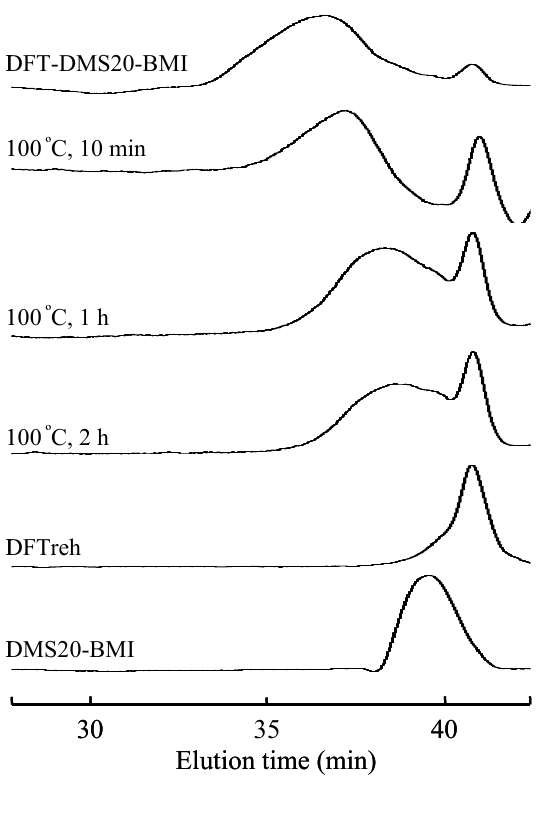
Figure 8. GPC traces of DFT-DMS20-BMI kept heated at 100 °C in DMF for the indicated